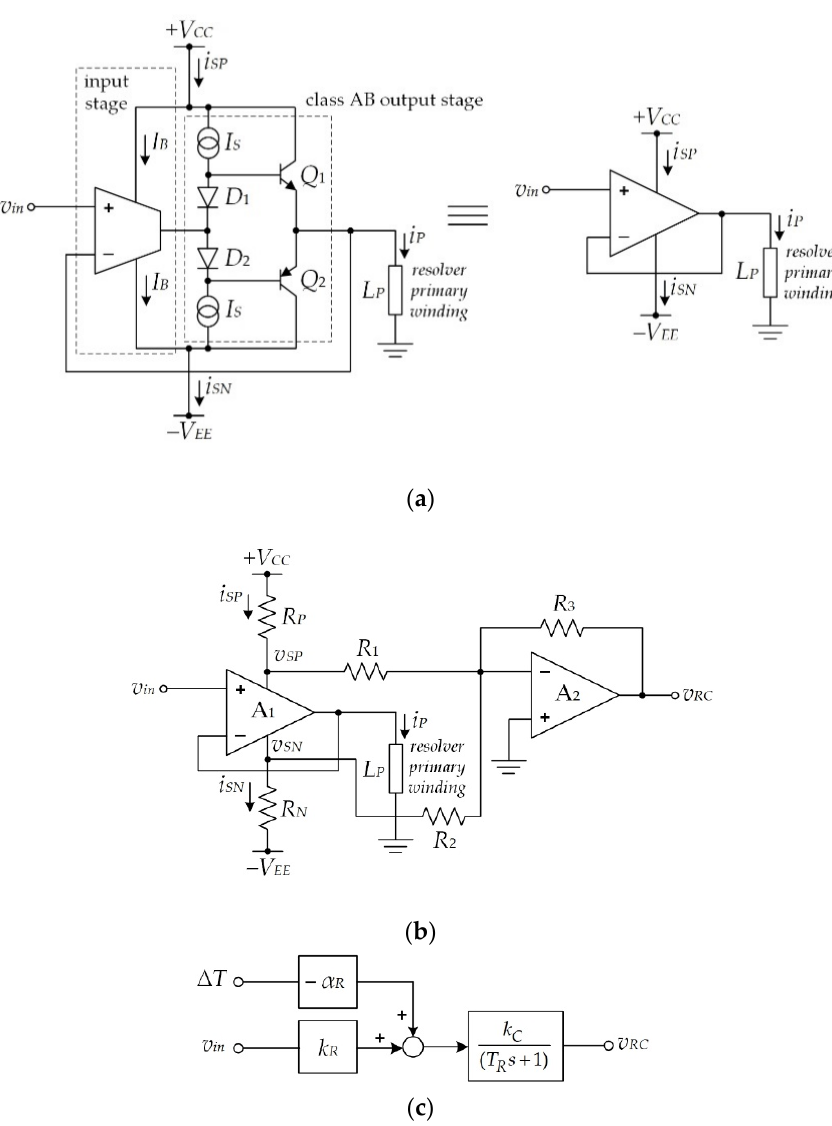
Figure 2. ( a ) Opamp equivalent circuit; ( b ) opamp supply-current sensing technique; ( c ) block diagram of primary winding current extraction including the temperature effect.